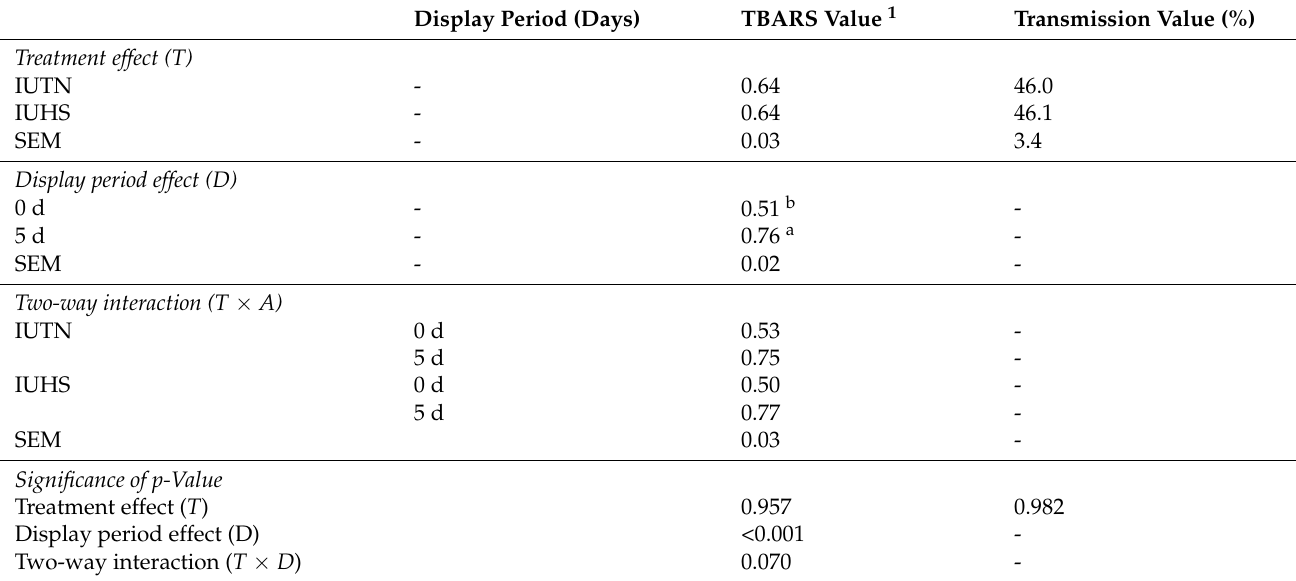
Table 6. Main and interactive effects of IUHS treatment and aerobic display storage on lipid oxidation and transmission value of pork loin muscle ( n = 10/treatment).